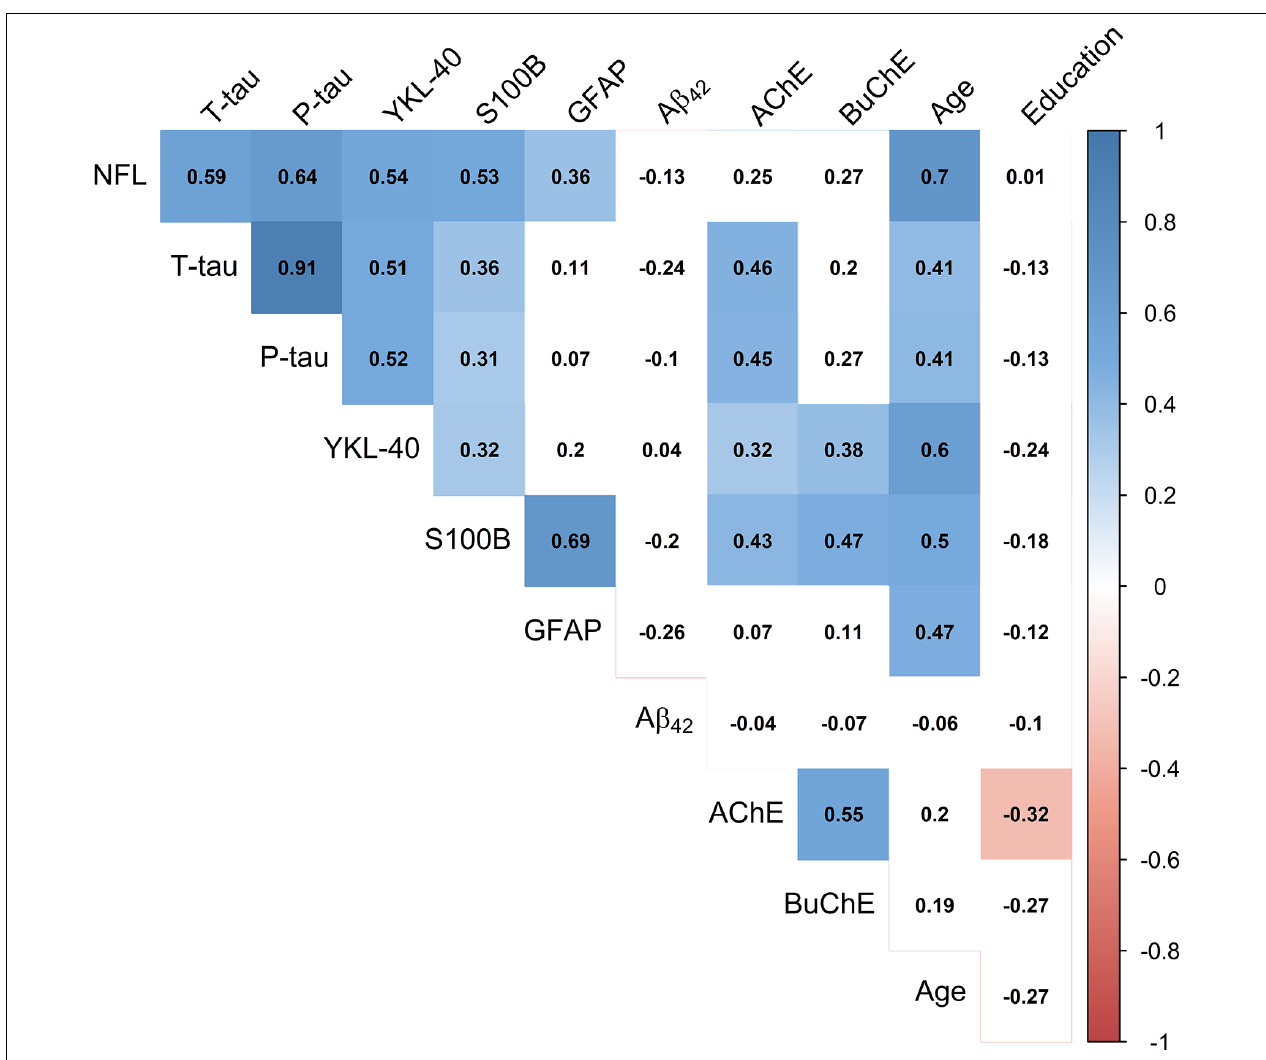
FIGURE 3 | Correlation matrix depicting Pearson’s coefficients between CSF activity of cholinergic enzymes, CSF protein levels, age and education. Colored squares indicate statistical significance ( p < 0.05). Blue and red colors present positive and negative coefficients, respectively. Values of CSF proteins (A β 42 , T-tau, P-tau, NFL, YKL-40, S100B, and GFAP) were natural log-transformed.